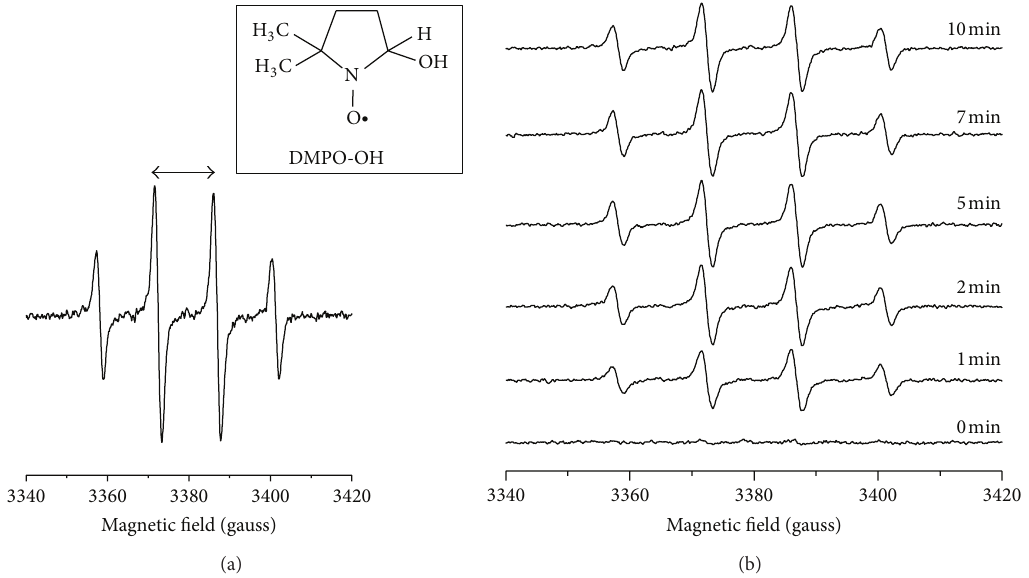
Figure 7: (a) EPR spectrum of the DMPO-OH adduct (structure shown in the inset). (b) Variation of the DMPO-OH resonance lines with the UV-Vis irradiation time for the TS aqueous